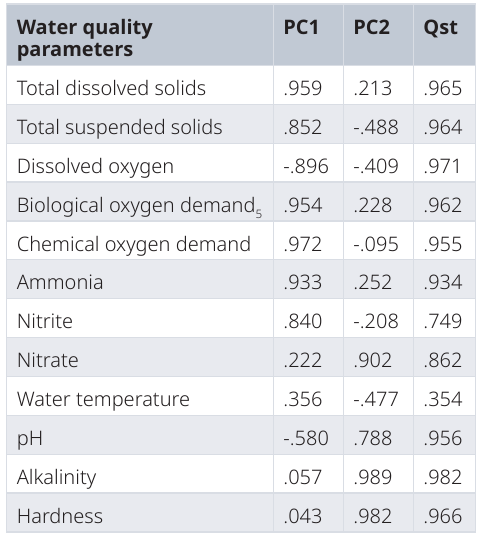
Table 3. Principal component loading and degree of divergence in quantitative traits among samples (Qst) of the water quality parameters.